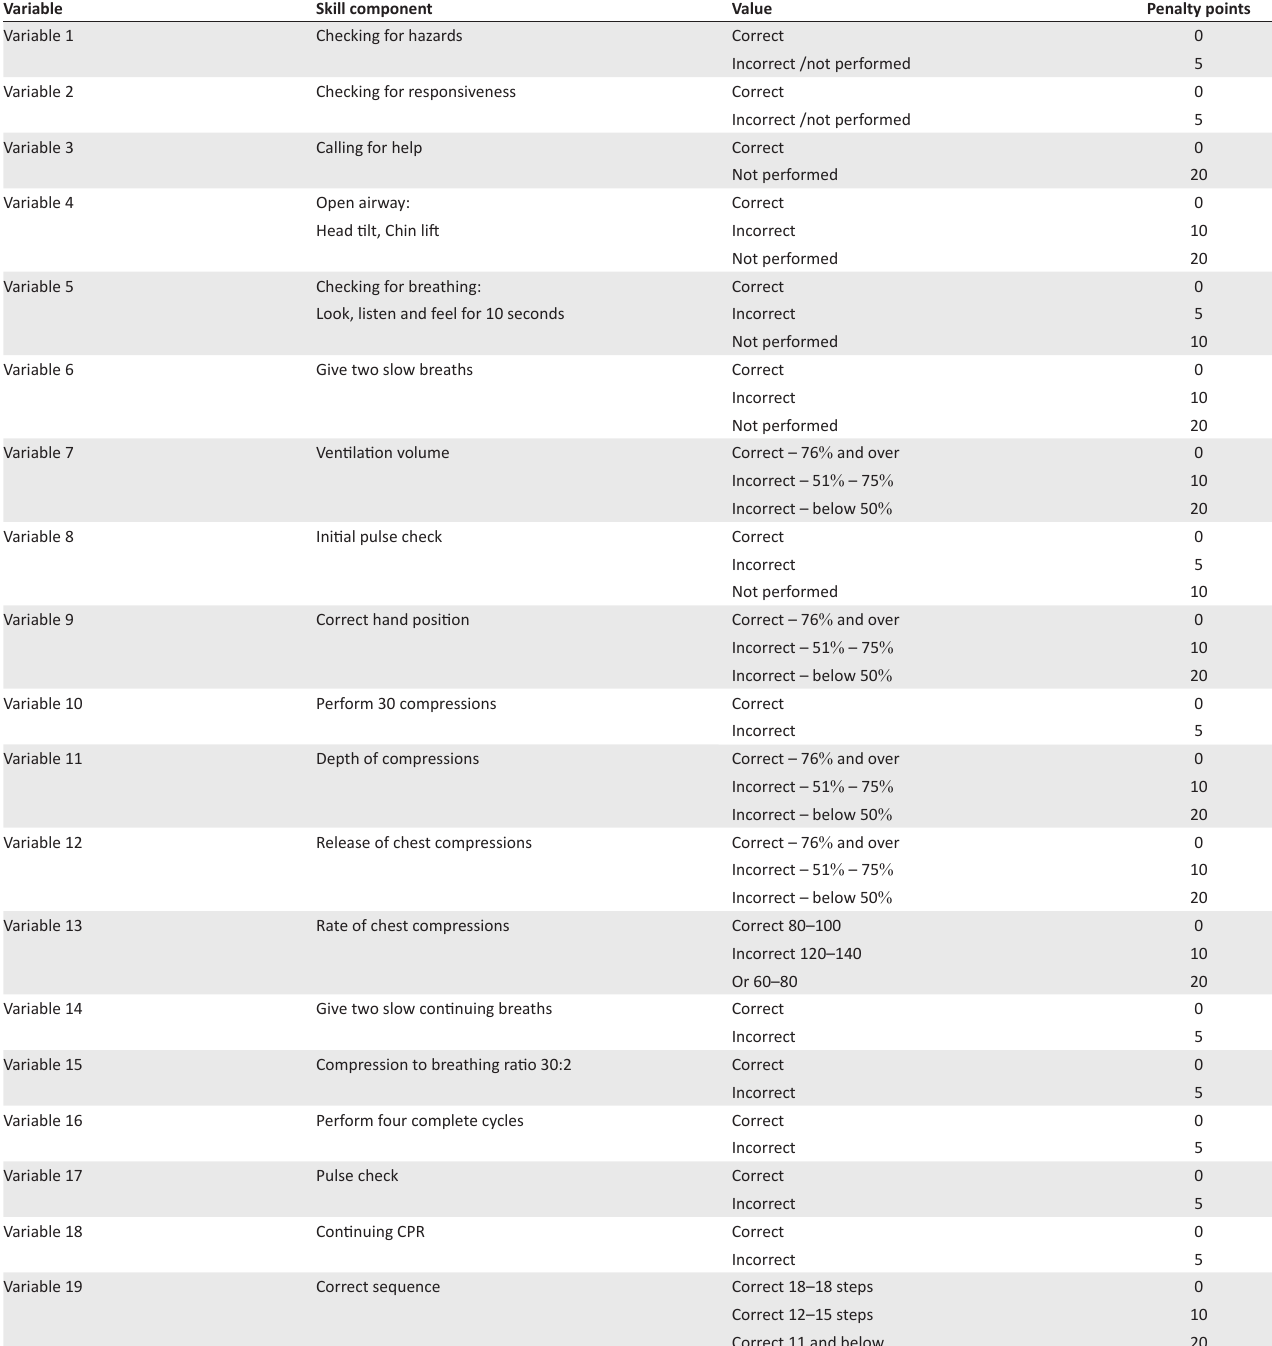
TABLE 2: Practical test – cardiopulmonary resuscitation skills, one